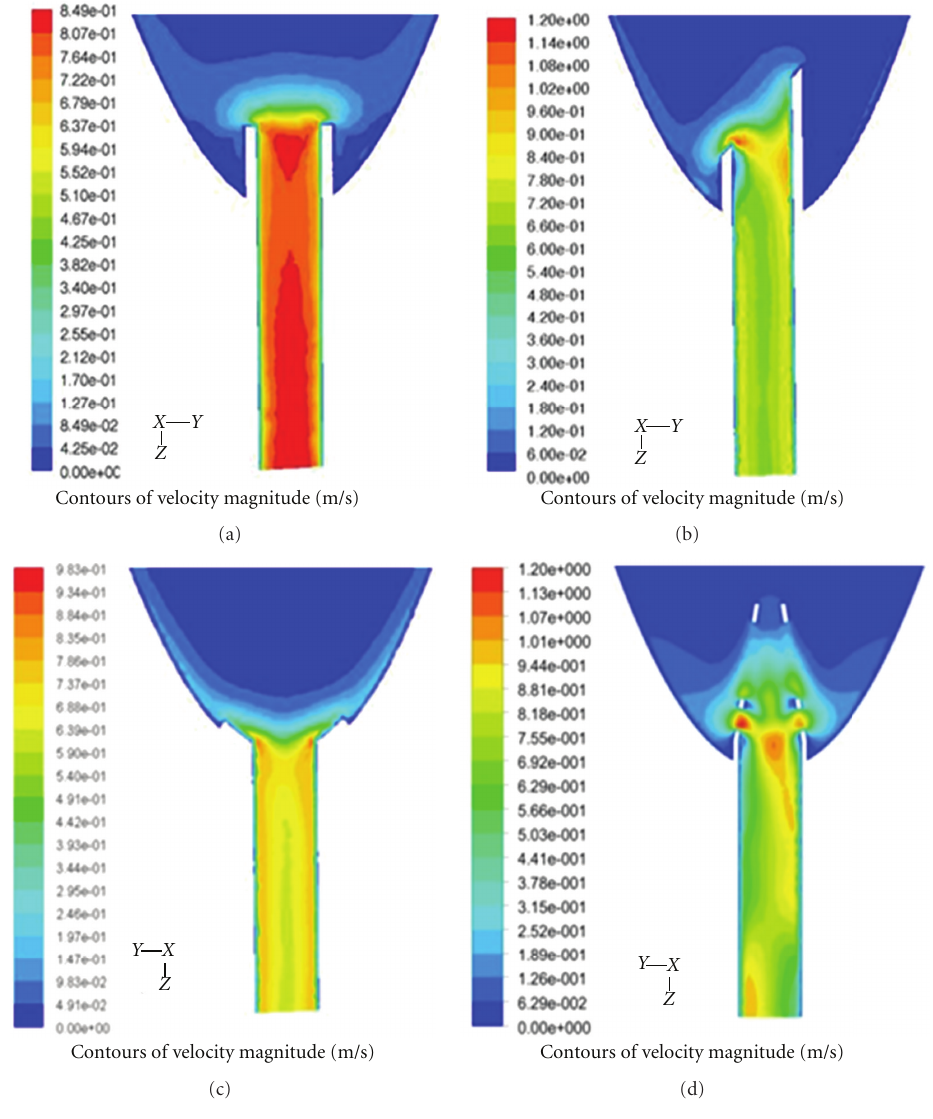
Figure 4: Velocity contour from tip to outlet: (a) blunt, (b) beveled, (c) trumpet, and (d)